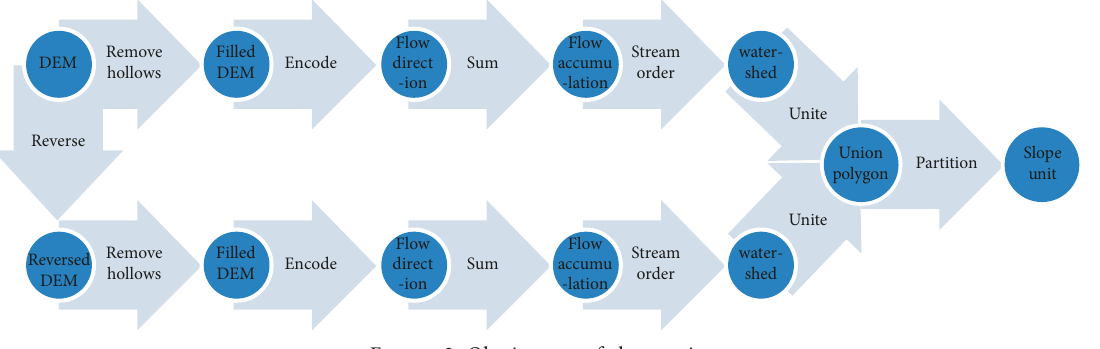
Figure 3: Obtainment of slope unit.